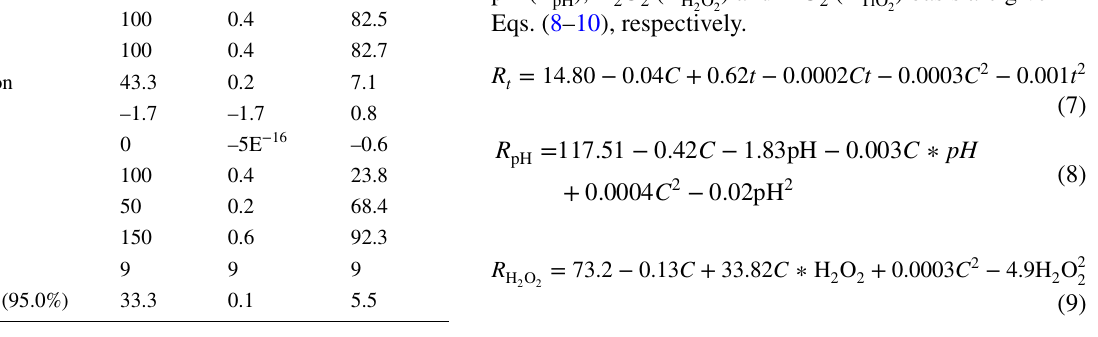
Table 4 Descriptive statistics of the data used for R TiO Descriptive statistics